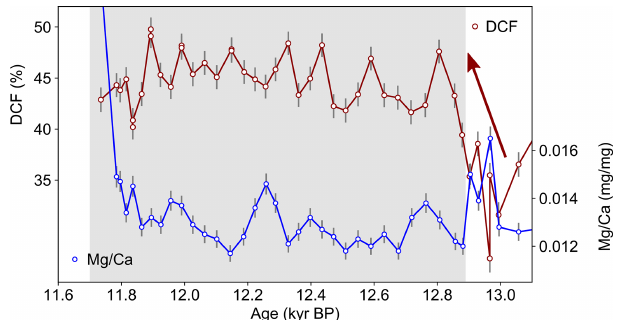
Figure 8. DCF and Mg / Ca of stalagmite M1-5 for the YD (gray area). DCF increases sharply at the onset of the YD (red